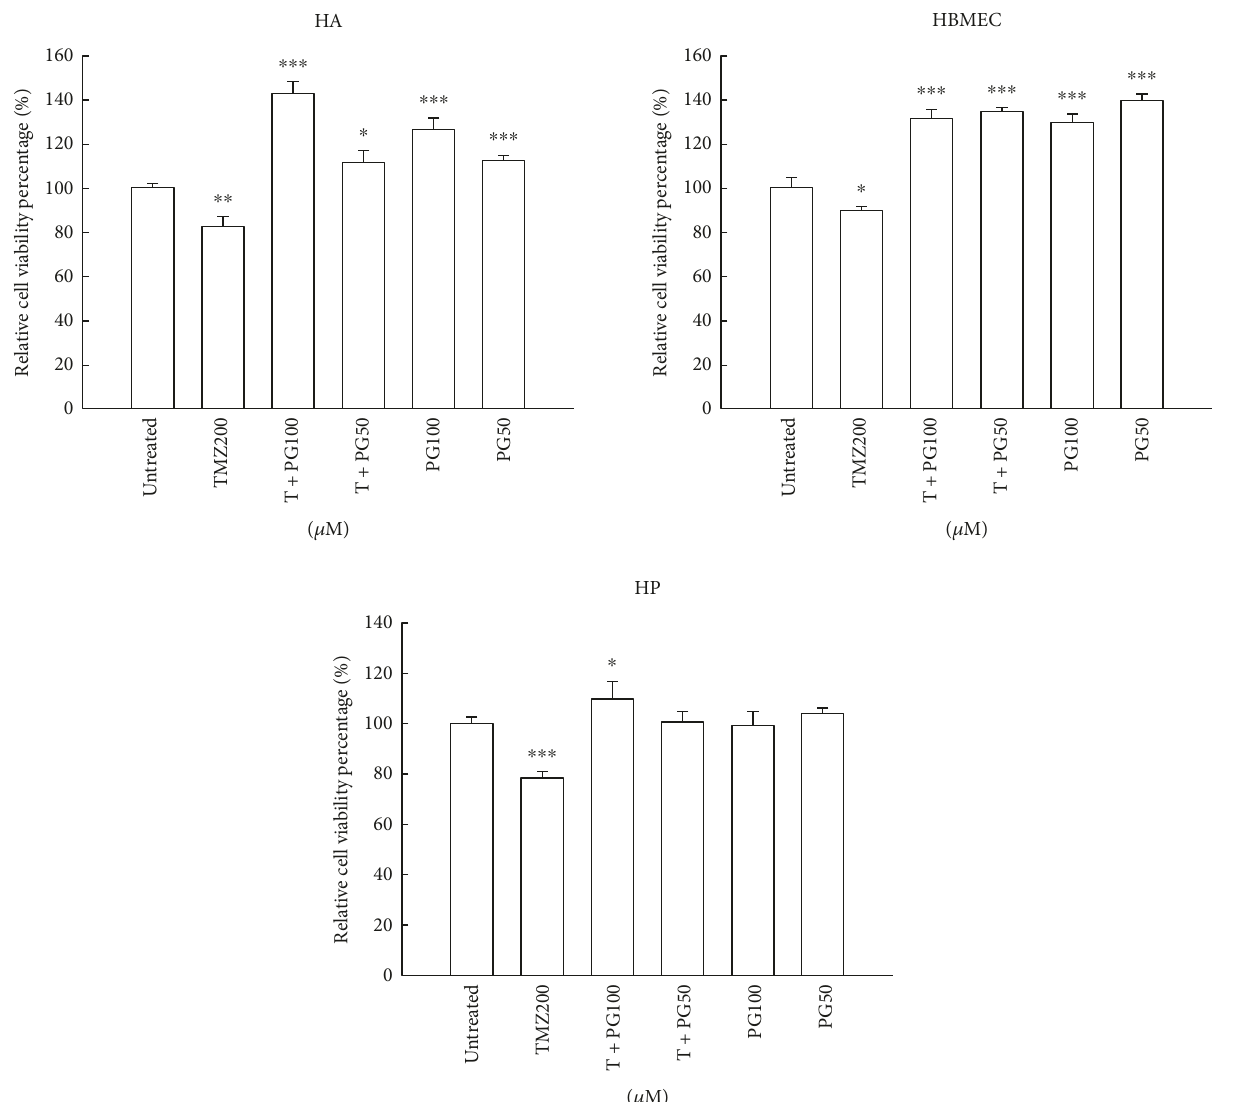
Figure 7: Evaluation of cell viability with TMZ, PG, or TMZ/PG treatment in normal cell lines. HA, HBMEC, and HP cells (1 × 10 4 ) were seeded in each well of a 96-well cultured plate for 24 h and then treated with TMZ (200 μ M), PG (50 or 100 μ M), or their combination for 48h. After treatment, cell viability was determined by an XTT-based assay. The values are represented as mean ± standard deviation ( n = 5 – 8) of individual experiments. Signi fi cant di ff erences for the untreated group were ∗ P < 0 05 , ∗∗ P < 0 01 , and ∗∗∗ P < 0 001